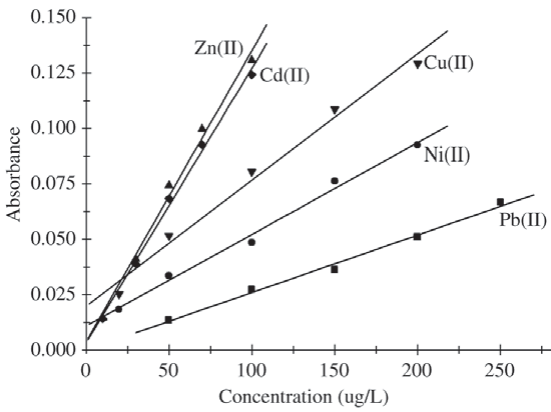
Figure 6. Calibration graphs obtained after preconcentration on a Cell-PAB column. Experimental conditions: 1 g Cell-PAB column, 1.0 mol/L HCl as eluent, flow rate of eluent 1.0 mL/min, sampling flow rate 1.0